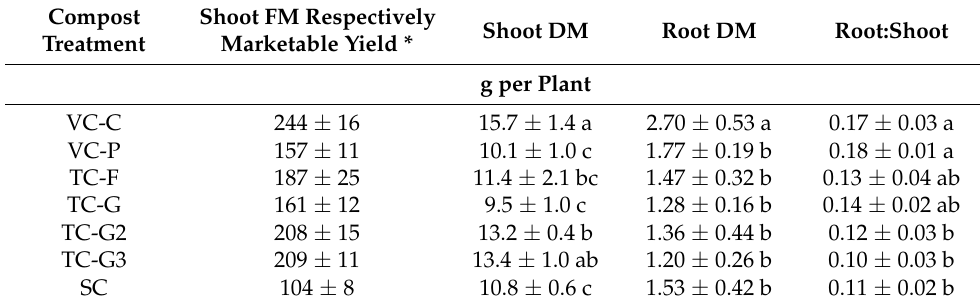
Table 3. Marketable yield of lettuce heads (FM per plant), shoot and root (DM per plant), and root:shoot ratio of lettuce plants. Values represent mean ± standard deviation ( n = 5). Different letters reflect that means significantly differ from one another (HSD, Tukey test, α = 0.05; n = 5). * Marketable yield (shoot FM) was not normally distributed; therefore, no indications of statistically significant differences are included here. DM, dry matter; FM, fresh matter; SC, sand control; TC-F, thermophilic compost from fecal matter; TC-G, thermophilic compost from green waste; TC-G2 and TC-G3, thermophilic compost from green waste with additional N fertilization; VC-C, vermicompost with coir bedding material; VC-P, vermicompost with paperboard bedding